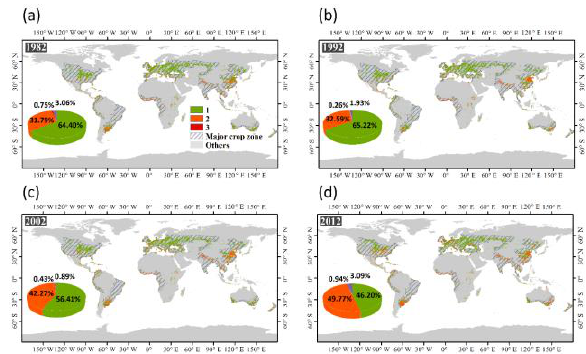
Figure 4. Spatial distribution of multiple cropping system